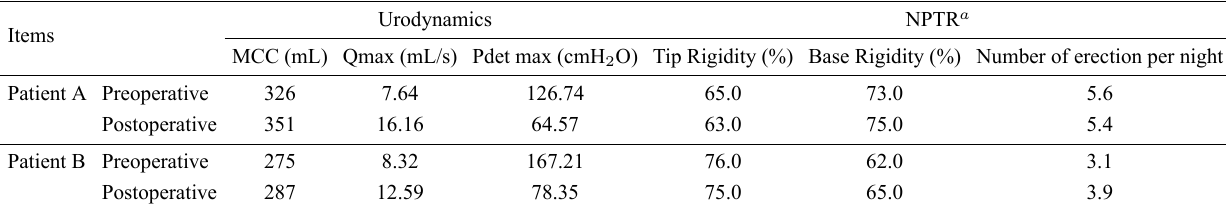
Table 1. Pre- and postoperative urodynamics and erection function (n = 2).